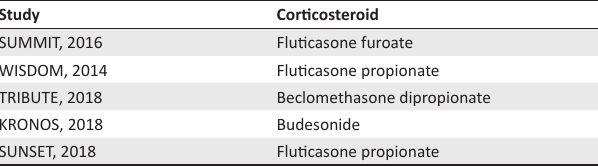
TABLE 1: Studies in which inhaled corticosteroids conferred no additional risk of pneumonia compared to placebo or bronchodilator.